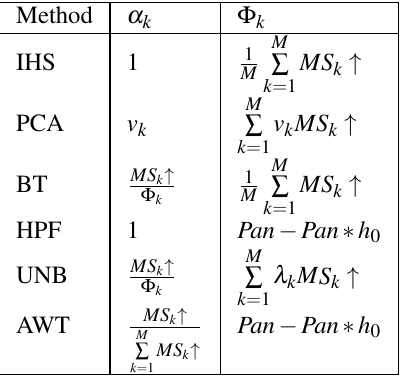
Table 1: Image fusion methods